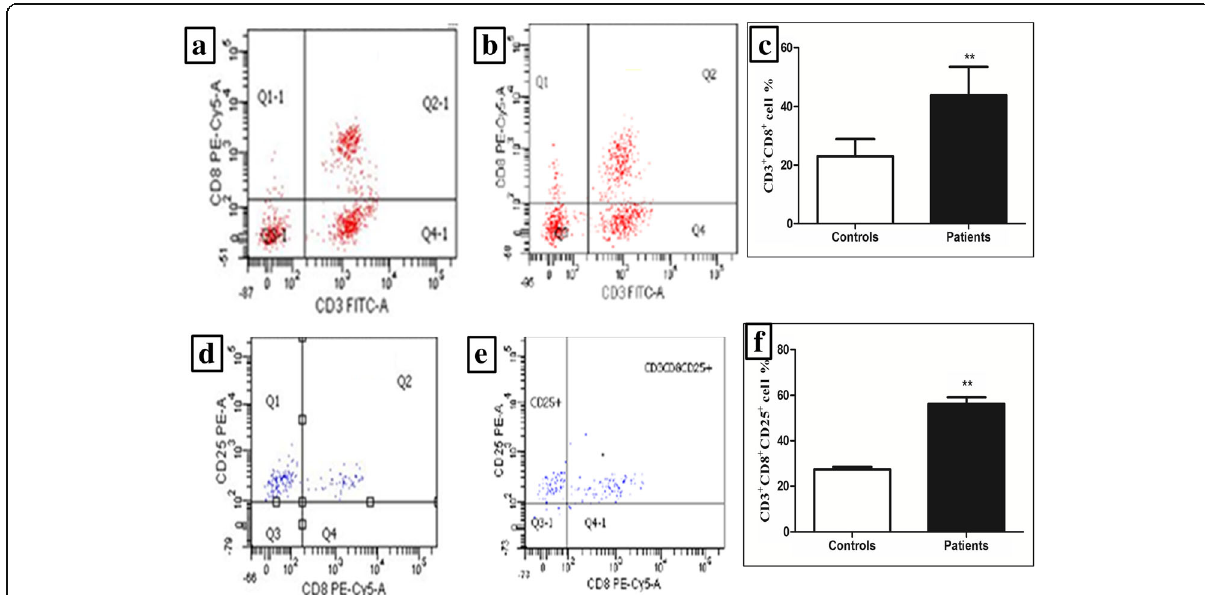
Fig. 2 a Dot plot of CD3 + CD8 + T cells in controls ( b ) Dot plot of CD3 + CD8 + T cells in patients ( c ) Statistical analysis of CD3 + CD8 + T cells in controls and patients ( d ) Dot plot of CD3 + CD8 + CD25 + T cells in controls ( e ) Dot plot of CD3 + CD8 + CD25 + T cells in patients ( f ) Statistical analysis of CD3 + CD8 + CD25 + T cells in controls and patients. All values are calculated as Mean ± SD. ** p <